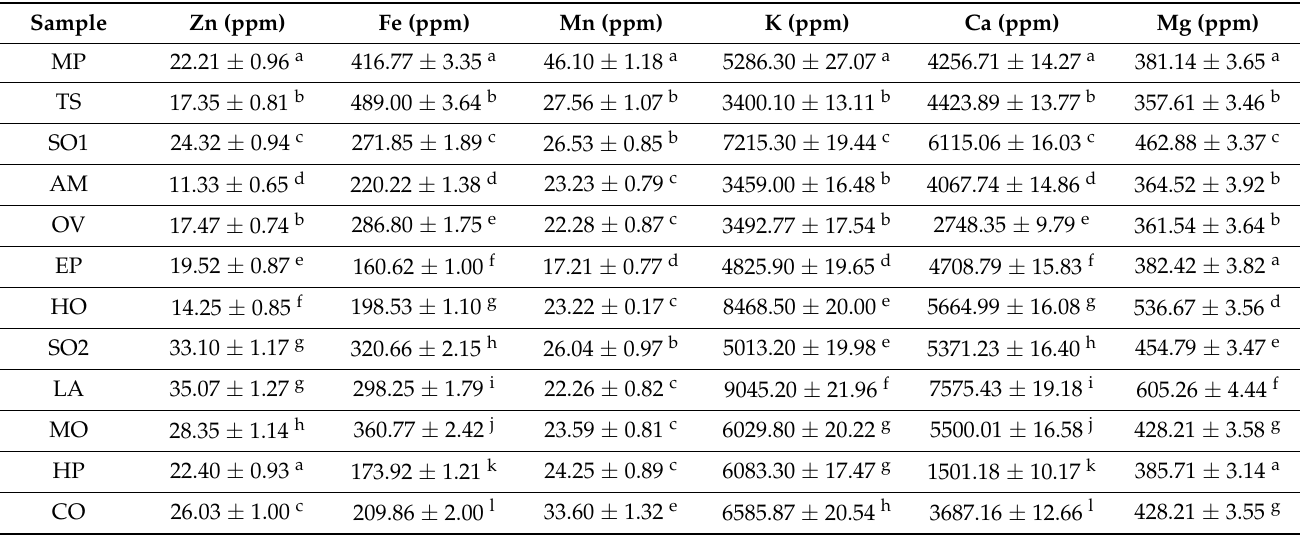
Table 3. Macro- and microelement content of medicinal